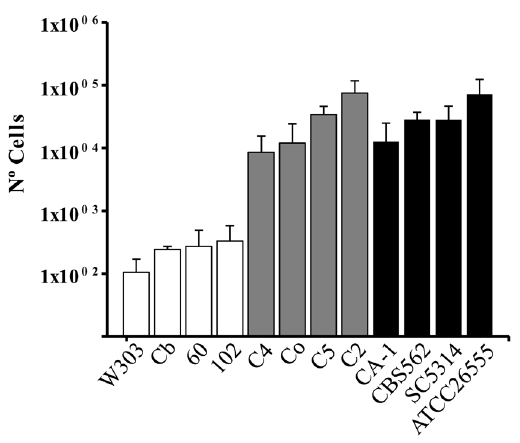
Figure 1. Number of yeast cells that were able to cross the endothelial barrier. To perform this assay we established HUVEC monolayers in Transwell® filter inserts in 24 well plates. 24 hours after apical addition of various strains of S. cerevisiae , C. albicans and C. glabrata , yeast cells from the basolateral compartment were incubated on YPD plates and colonies were counted after one day of growth. Values were obtained after plating several dilutions of the basolateral compartment media. Average of three experiments and standard deviation is shown. To determine statistically significant data, Student t -tests were performed in Excel with 0.05 as the p -value.